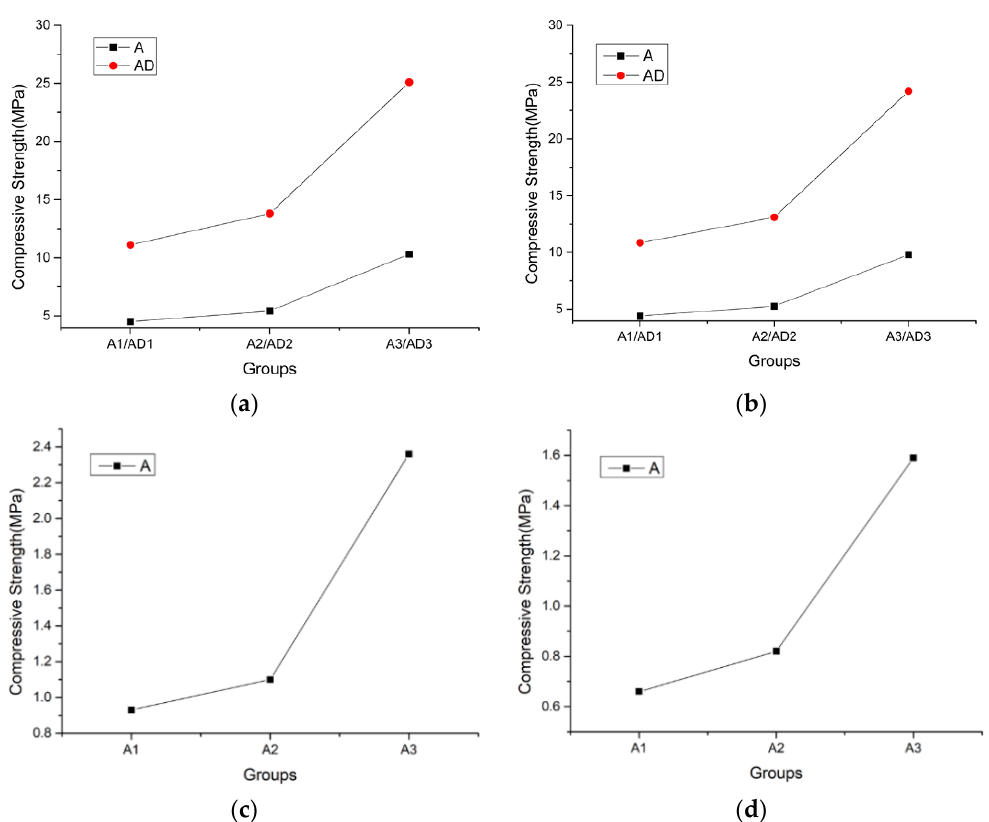
Figure 9. Variation in the strengths in groups A and AD. ( a ) Variation in cubic compressive strengths; ( b ) Variation in prism compressive strengths; ( c ) Variation in shear strengths; ( d ) Variation in splitting tensile strengths.